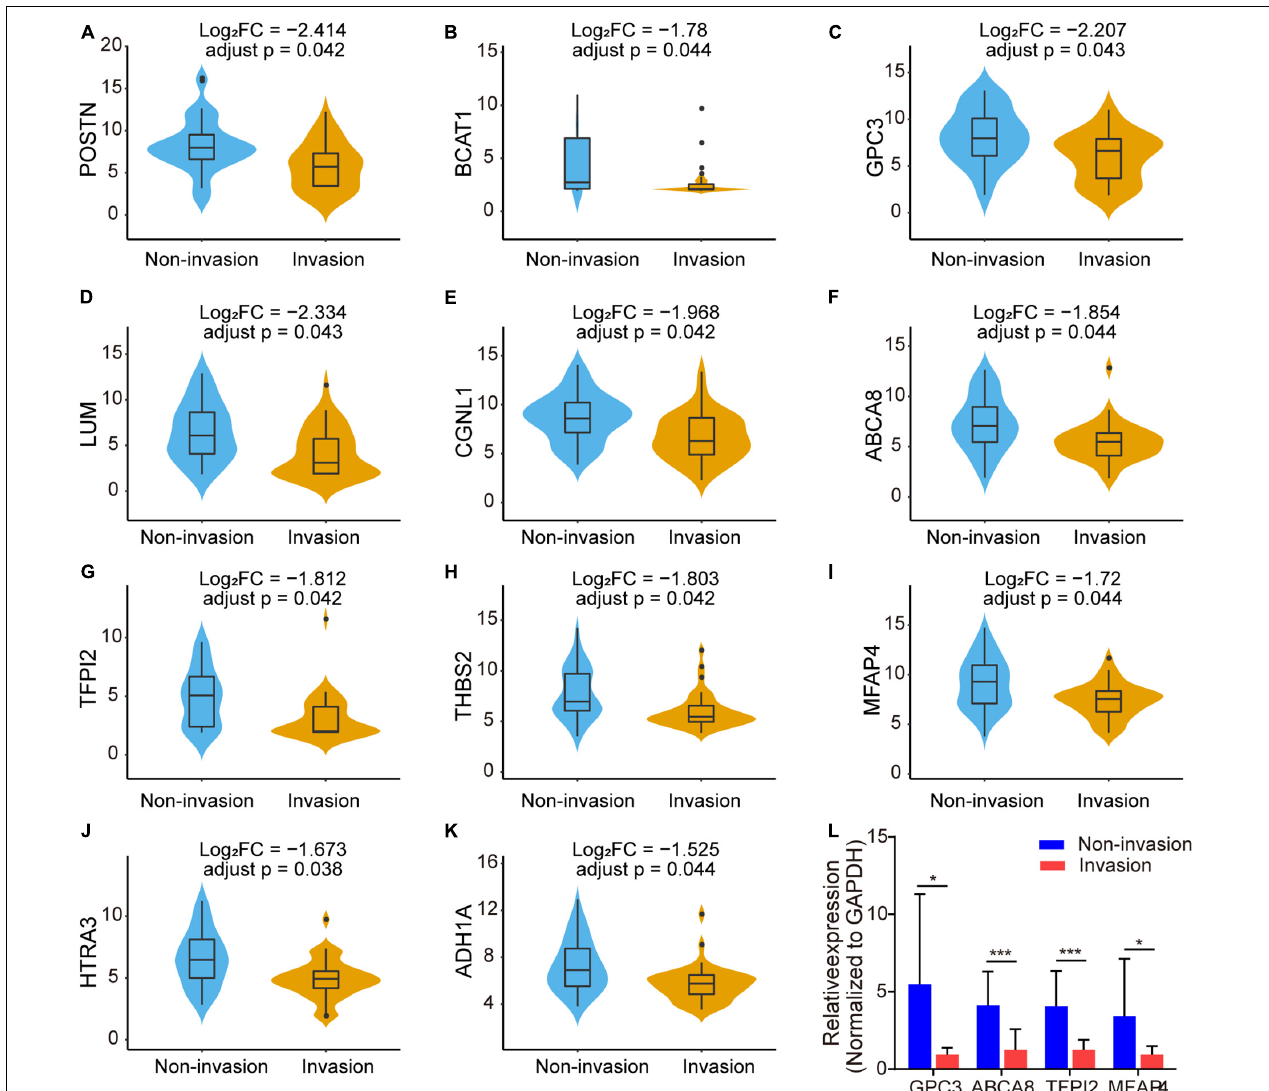
FIGURE 5 | Box plots showing the different expression level of 11 genes with adjust p < 0.05 and | Log 2 (fold change)| > 1.5 in NFPA CS invasion status [ (A–K) , FC: fold change]. (L) Validation of differentially expressed genes in the NFPAs through qRT-PCR. Relative expression of GPC3, ABCA8, TFPI2, and MFAP4 between CS invasive NFPAs and non-invasive NFPAs. Data were analyzed using unpaired Student’s t -test. * p < 0.05; *** p <